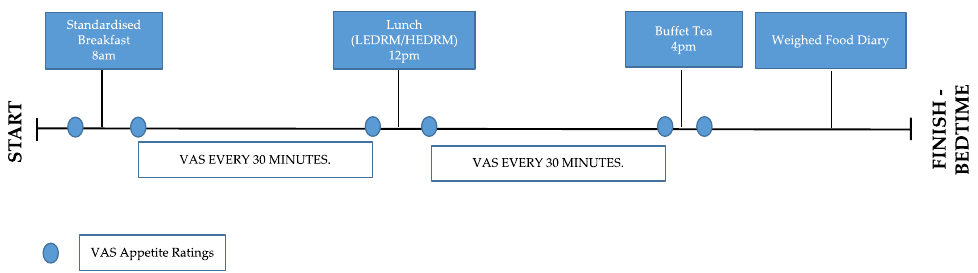
Figure 2. Timeline of study protocol for both test